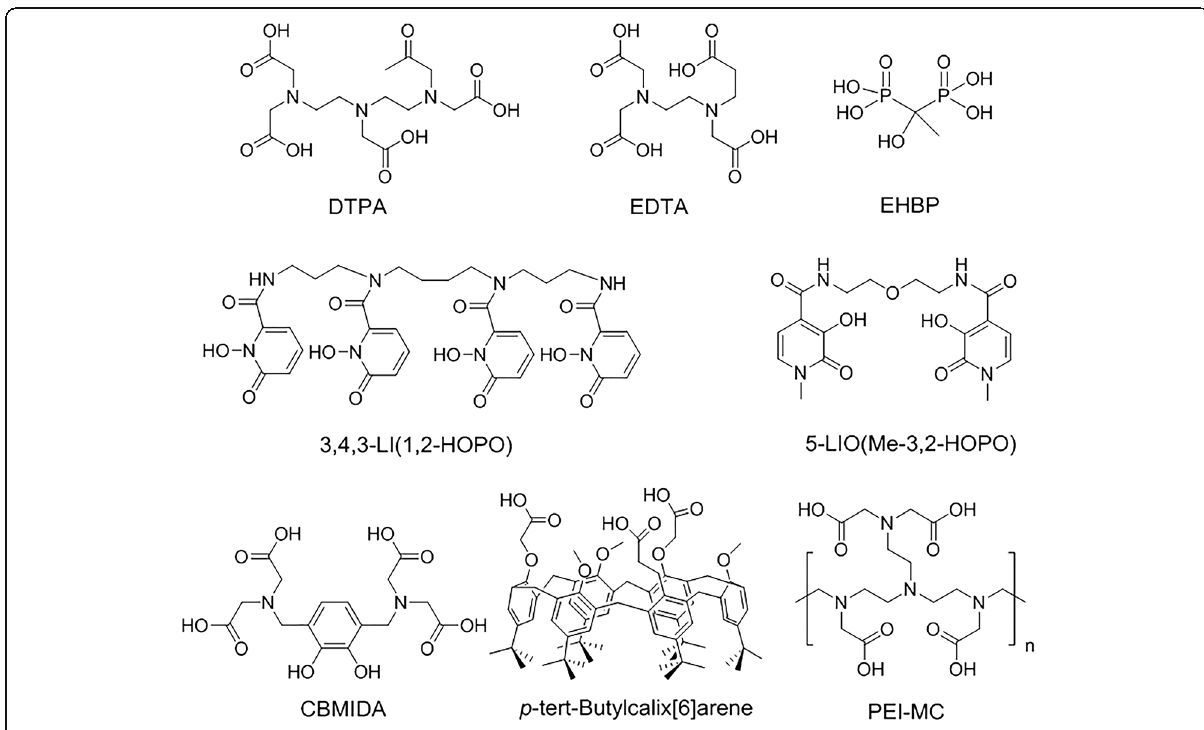
Fig. 2 The chemical structure of chelating agents for